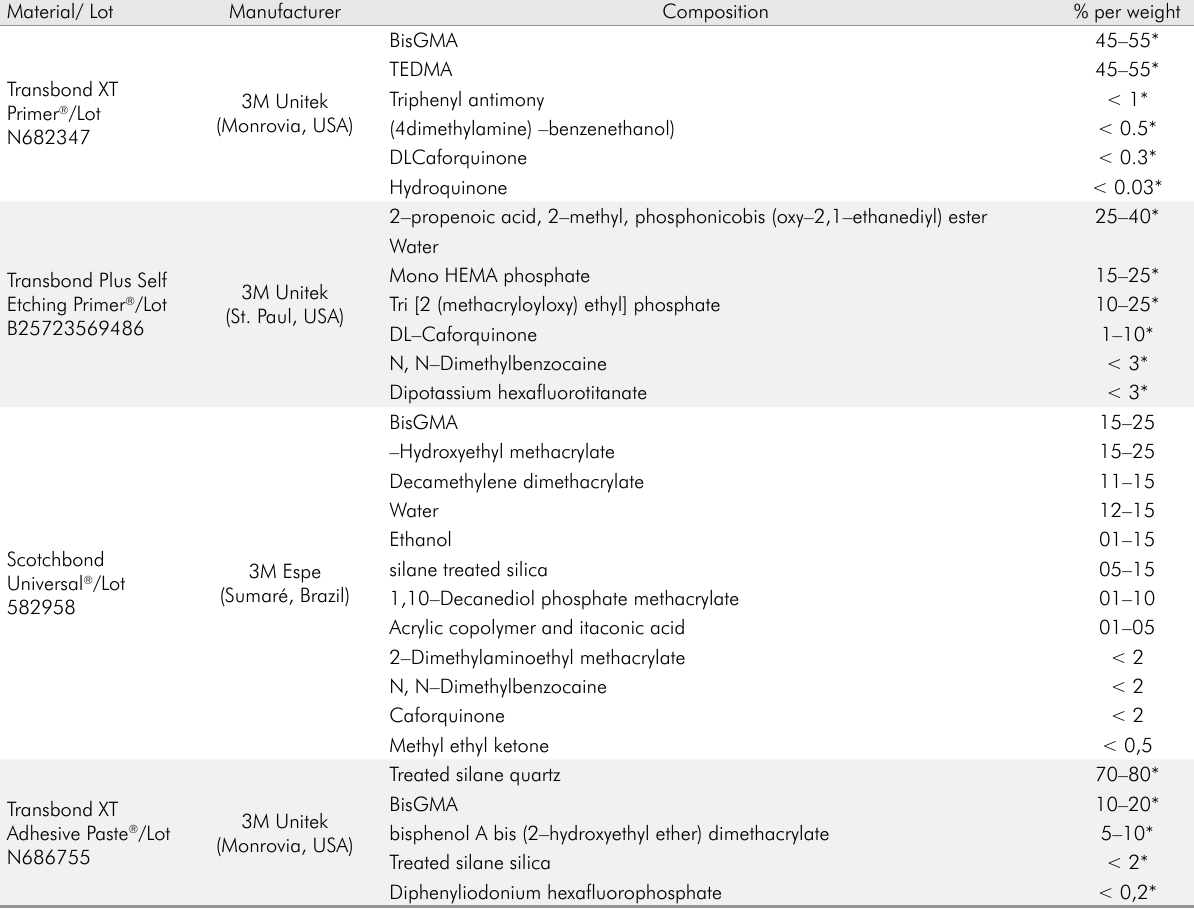
Table 1. Bonding materials used in this